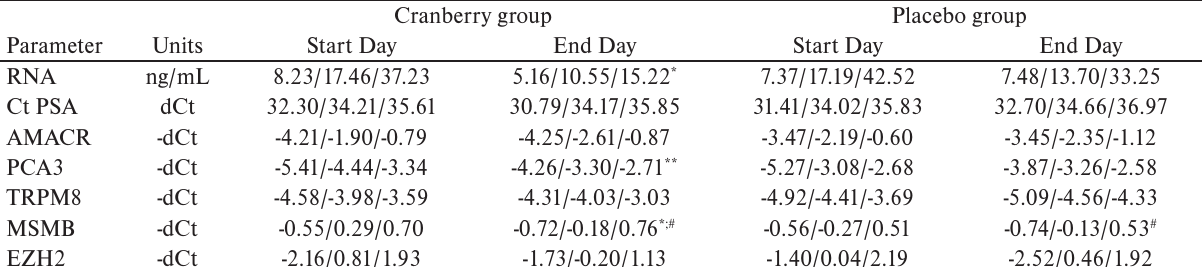
Table 6. RNA urine markers.